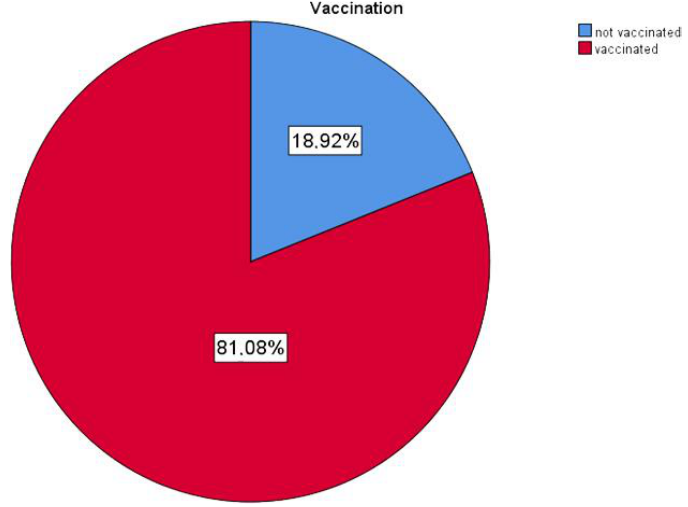
Figure 6. Vaccination distribution in patients. Table 1. Vaccination status of all responses.